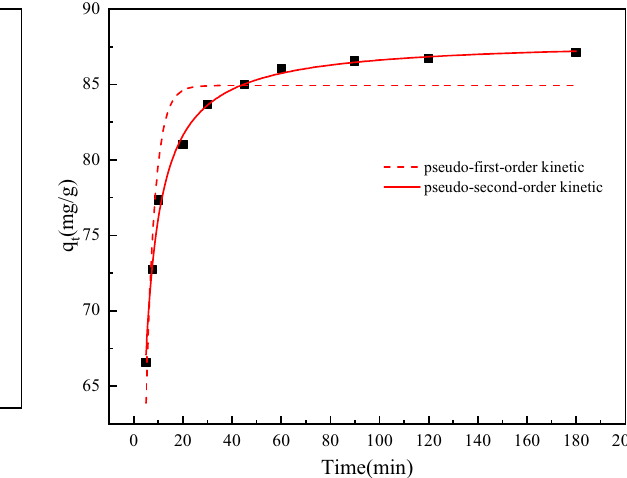
Figure 3: Adsorption kinetics experiment of LDH.